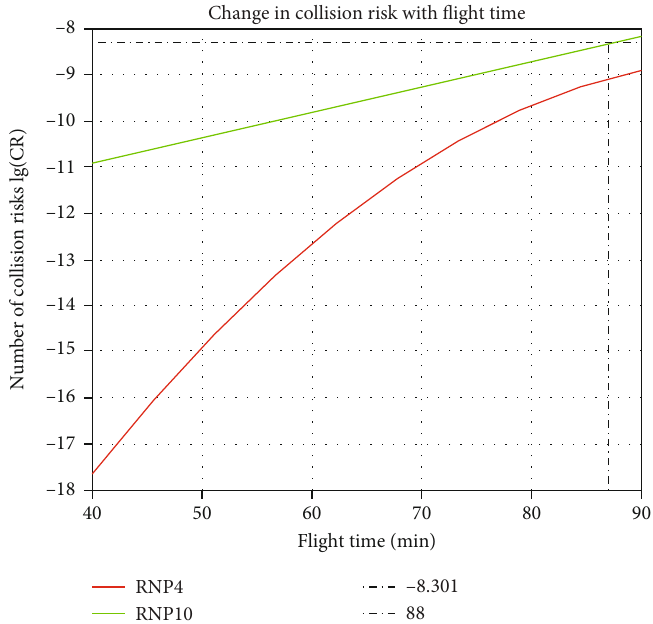
Figure 6: Collision risk changes with the fl ight time.